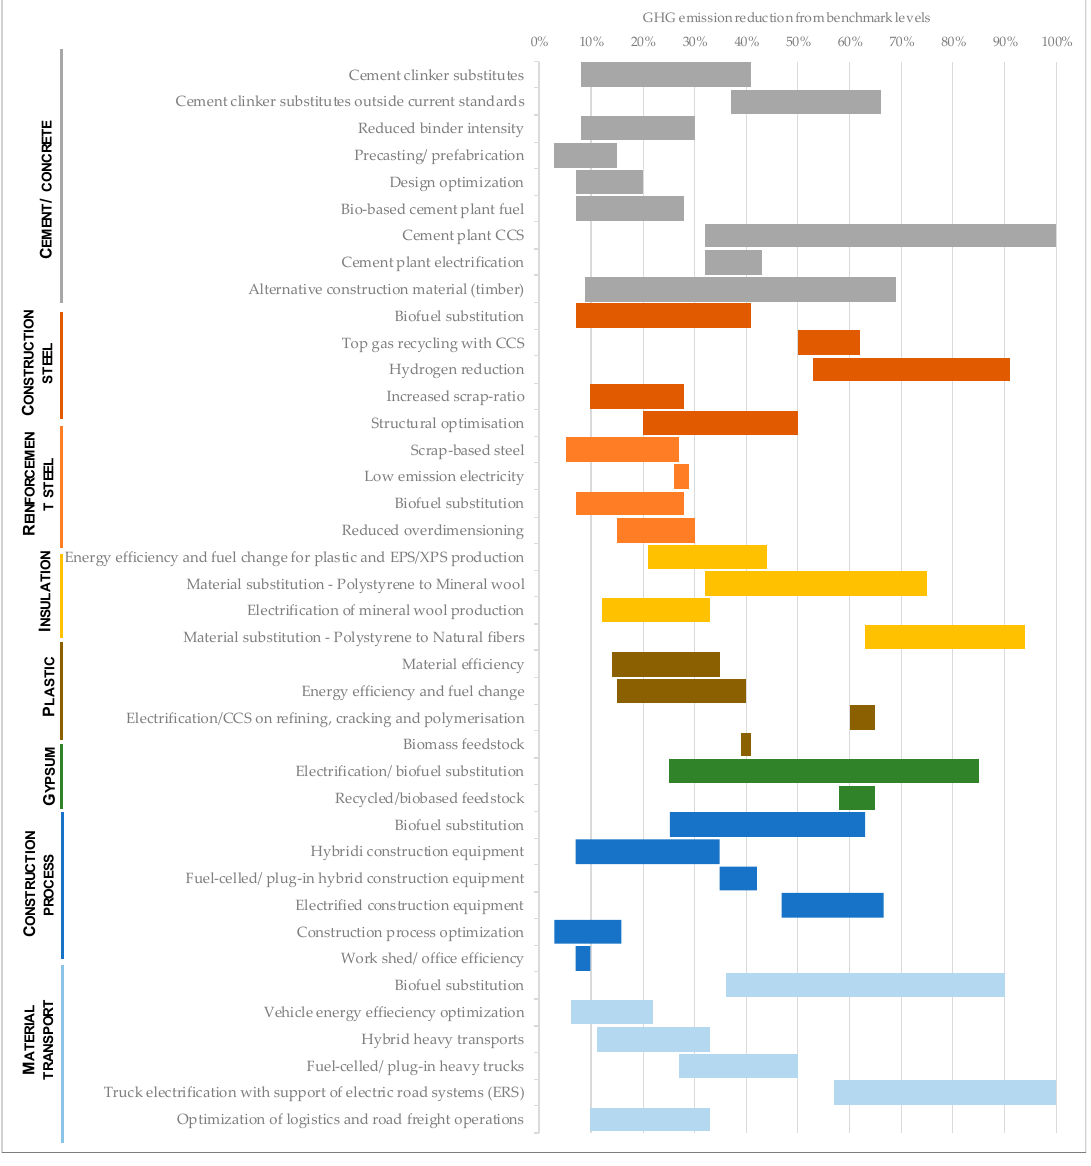
Figure 5. Range of greenhouse gas (GHG) emissions reduction potential for the abatement options identified in the literature review for the main emissions sources (color coded). The study analysis is based around reaching the medium-high range of the emission reduction potentials for each selected abatement measure when fully implemented. The Supplementary Material provides full details of measures for all activities, including timelines, potentials, and references.